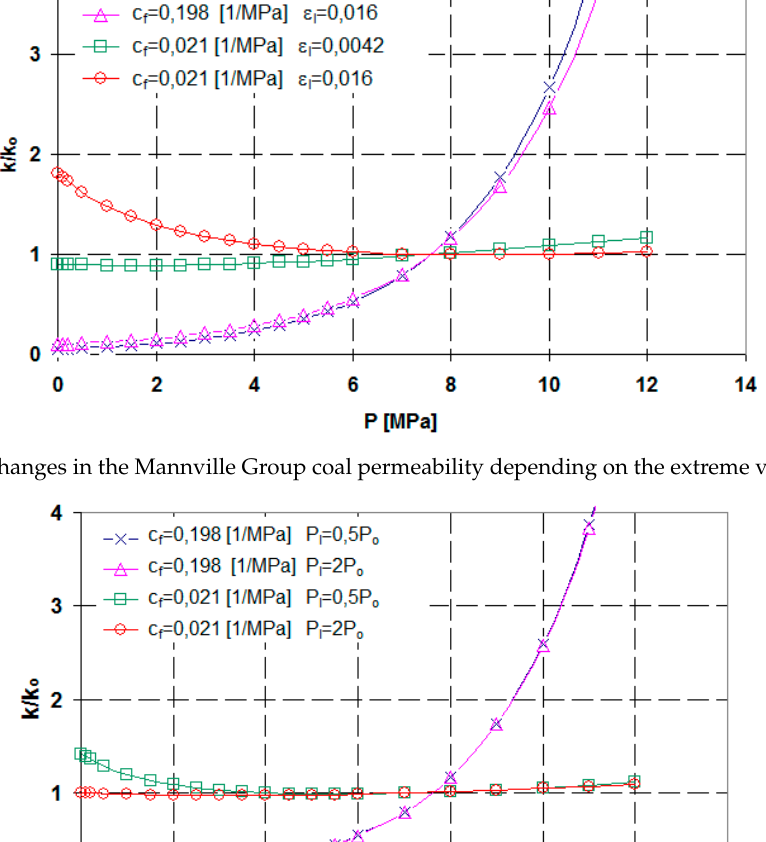
Figure 10. Changes in the Mannville Group coal permeability depending on the extreme values of P L . 344 3.4. Changes in Permeability in Relation to the Coal from the Cretaceous Mesaverde Group, Western Canada 345 Similar simulations were performed in relation to the changes in P l . The values of P L were matched with the greatest and smallest changes in k / k o from previous simulations for the two variants P L = 0.5 P o , and P L = 2 P o For the data from the Cretaceous Mesaverde Goup basin (Table 3), we presented how 346 permeability varies as a result of changes in methane’s pore pressure in relation to different cleat 347